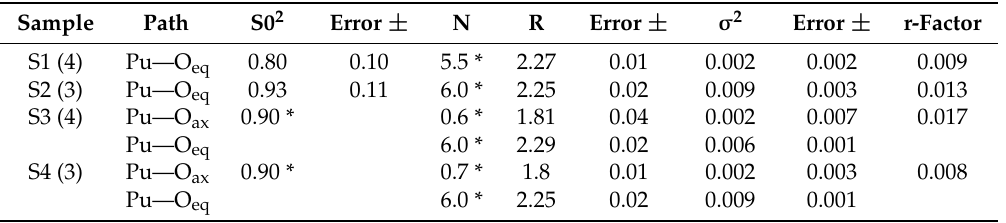
Table 3. EXAFS fitting parameters and statistics for the four analyzed samples. Here, S0 2 denotes the amplitude reduction factor, N denotes coordination number (shell occupancy), R denotes interatomic distance, σ 2 denotes the Debye–Waller factor and the ‘r-factor’ denotes the least squared residual for the overall fit. Parameters marked ‘*’ were fixed during the fitting process. Numbers in brackets are the number of spectra summed to provide the dataset for fitting. ‘ax’ and ‘eq’ denote the axial and